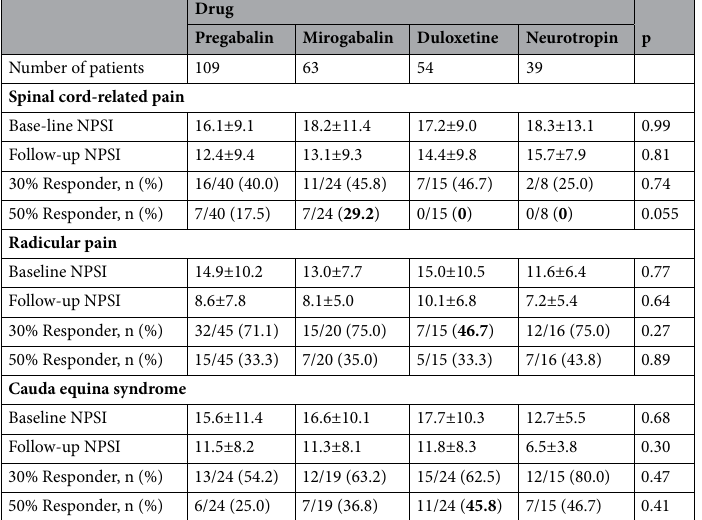
Drug pPregabalin Mirogabalin Duloxetine